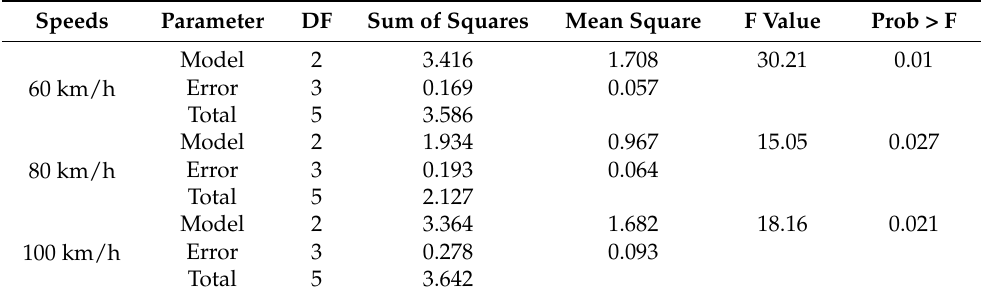
Table 9. ANOVA for fitting of driver’s visual workload intensity and TSIV under three-speed con- ditions.